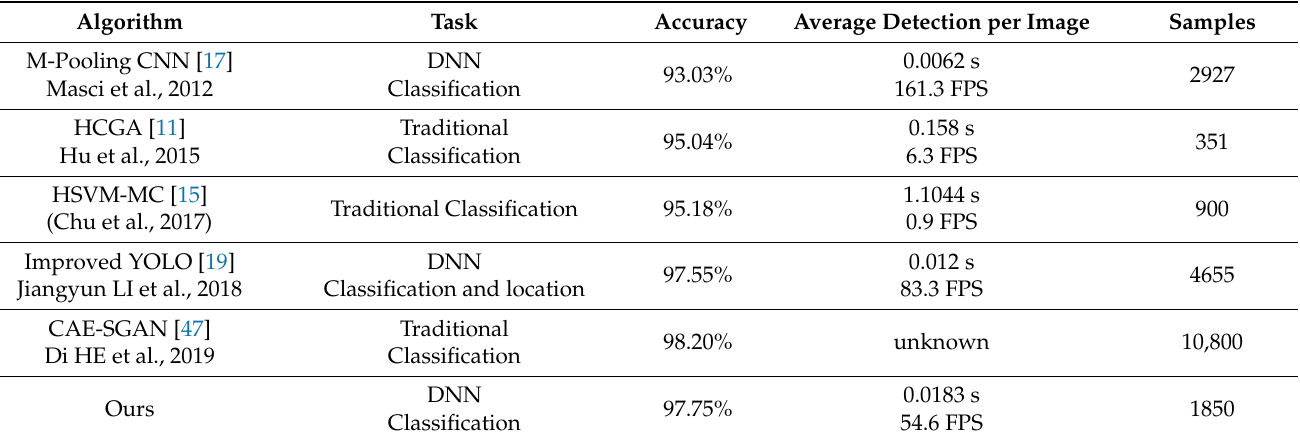
Table 3. Performance comparison between traditional algorithms and DNN algorithms.